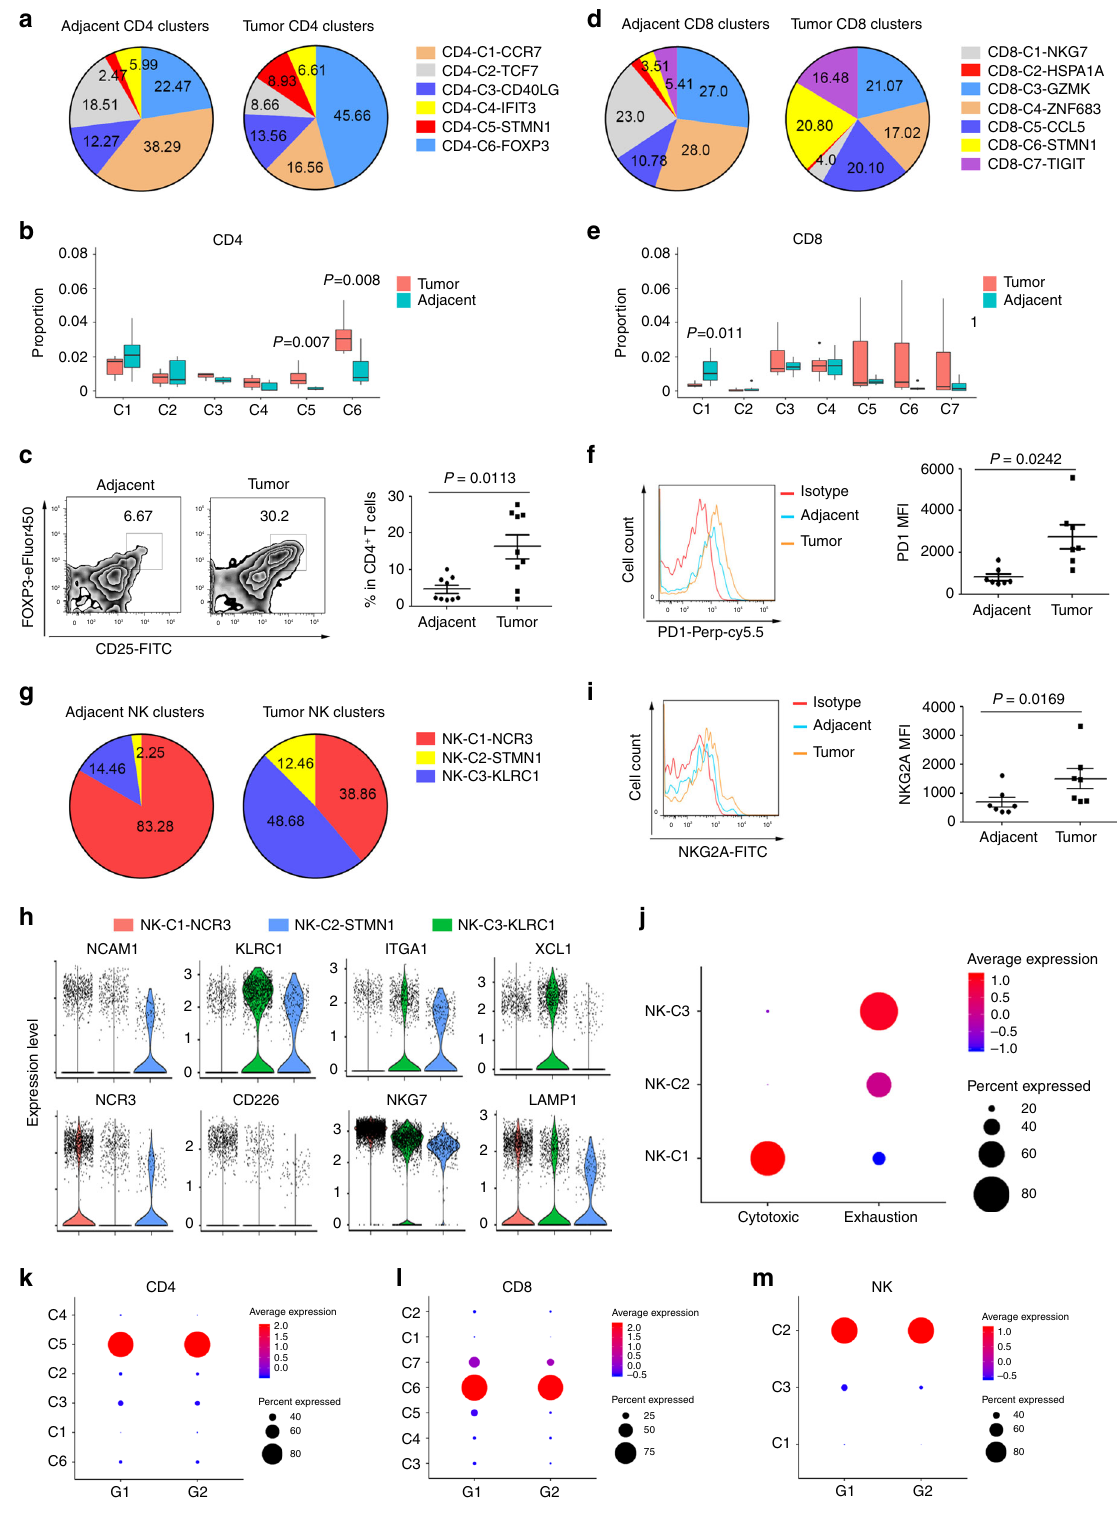
of branches, and Macro-C2-IL1RN was located in the middle (Fig. 5c). We further applied another algorithm Slingshot 37 to the same dataset and obtained comparable results (Supplementary Fig. 9b). However, we also observed a signi fi cant correlation between M1 and M2 signatures in macrophages (Supplementary Fig. 9c), which indicated a complicated macrophage polarization process in ESCC, which was consistent with other researchs 12,18 .